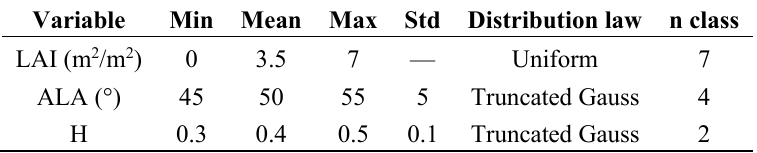
Table 2. Distribution of the canopy structure parameters of the scattering from arbitrarily inclined leaves (SAIL) model used to generate the training dataset.